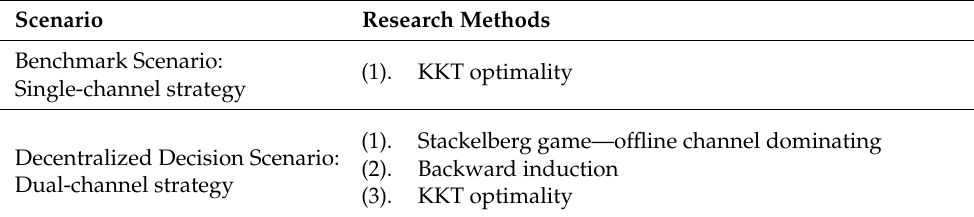
Table 2. Research methods used in this paper.